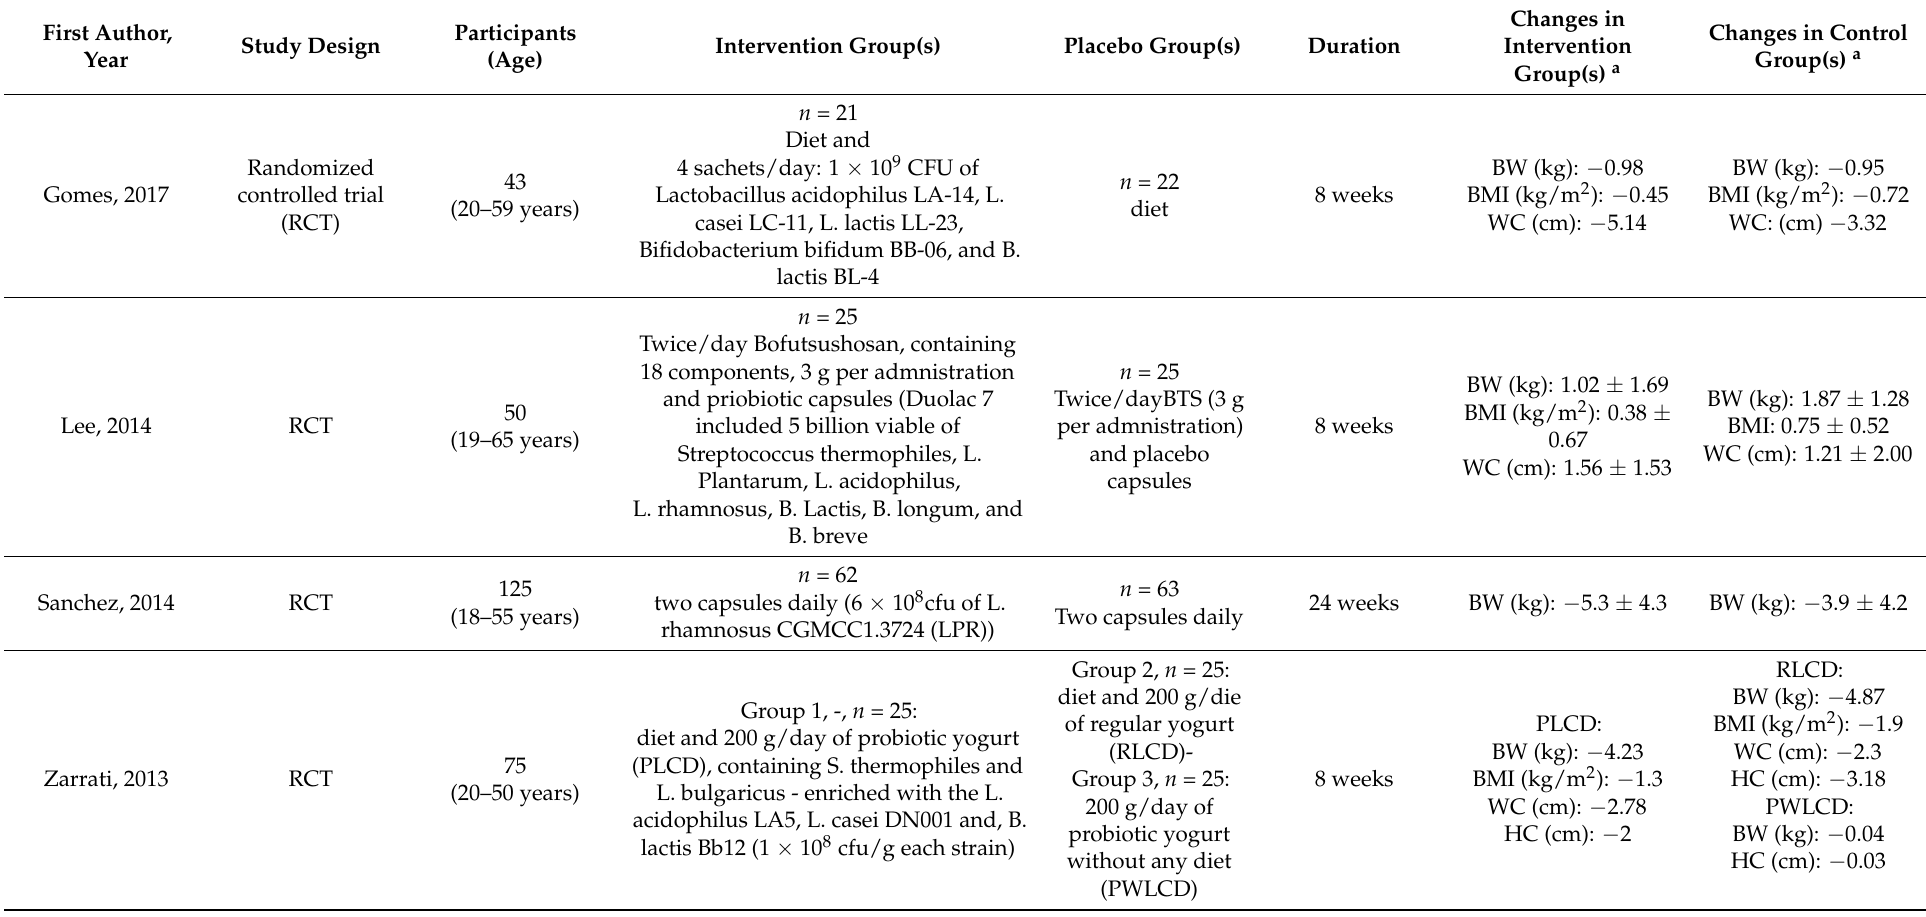
Table 1. Intervention studies on the effect of different probiotics on anthropometric